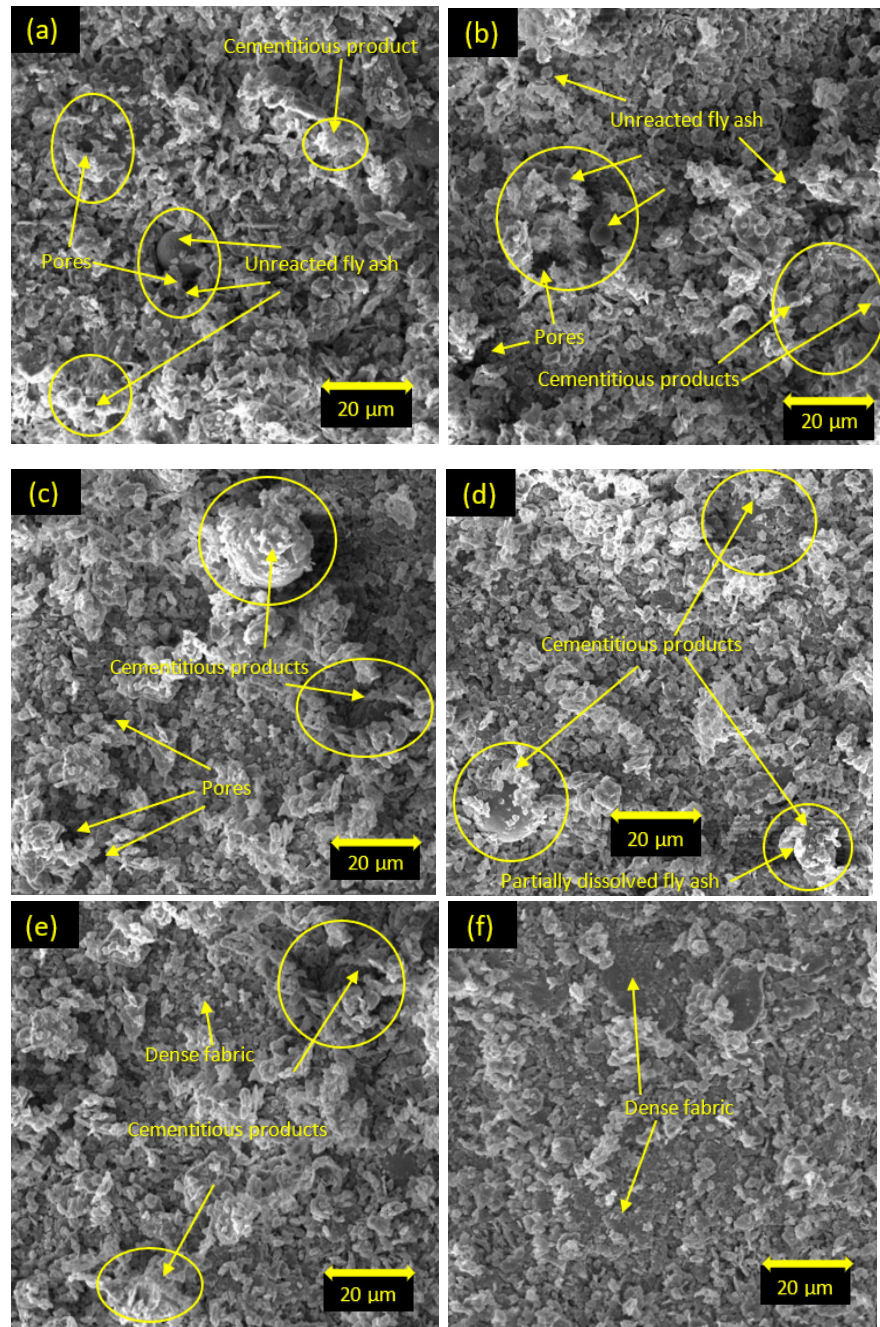
Figure 15. SEM images of soil stabilized with class C fly ash: ( a ) 15% C, one day of curing; ( b ) 25% C, one day of curing; ( c ) 15% C, seven days of curing; ( d ) 25% C, seven days of curing; ( e ) 15% C, 28 days of curing; ( f ) 25% C, 28 days of curing.